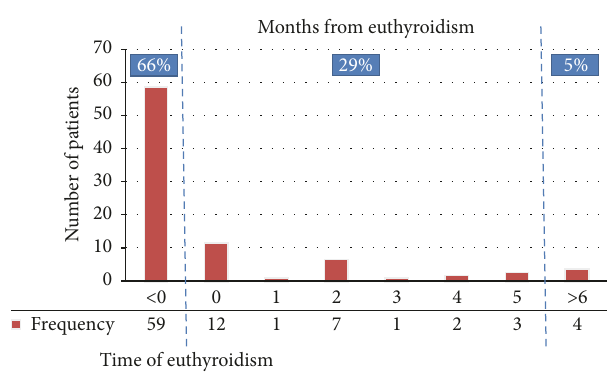
Figure 2: Time of spontaneous sinus